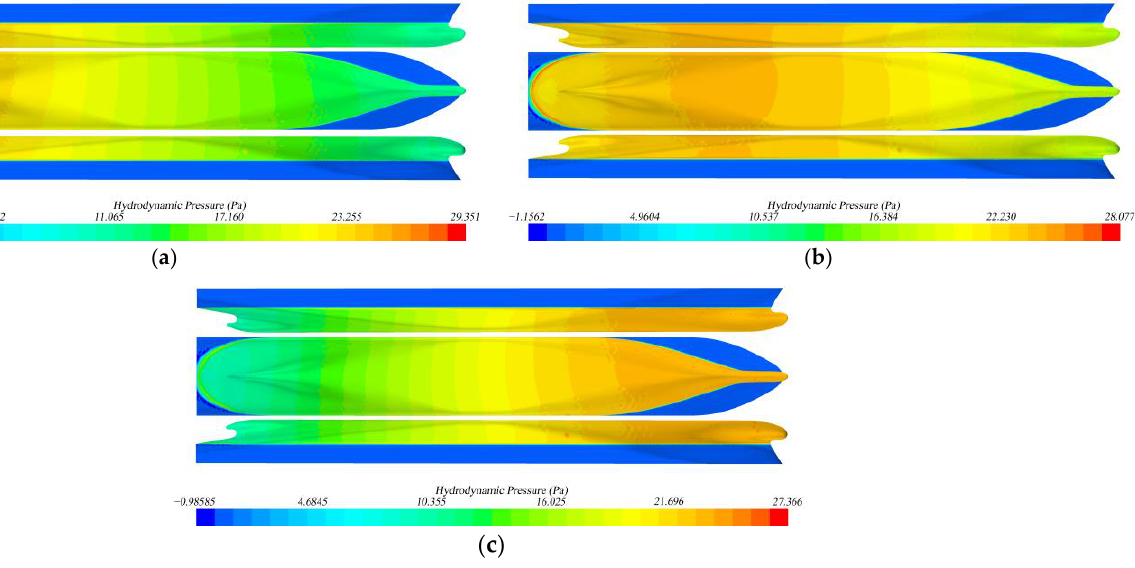
Figure 15. Pressure distributions on the moored ship affected by the solitary wave system. ( a ) Solitary wave crest passing the stern, ( b ) Solitary wave crest passing the midship, ( c ) Solitary wave crest passing the bow.